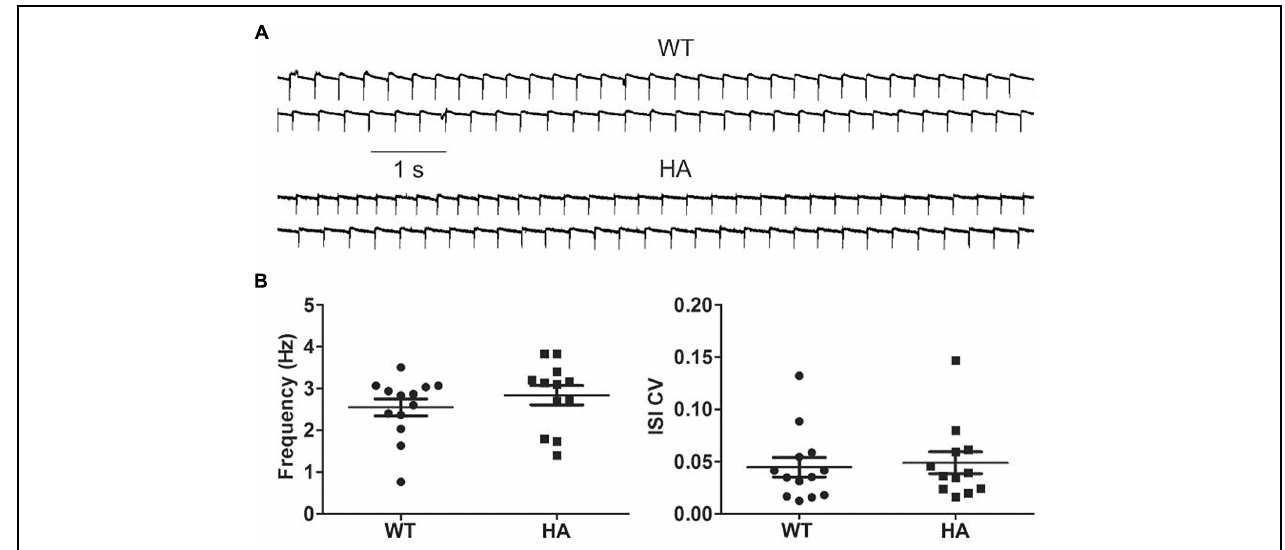
FIGURE 11 | Spontaneous pacemaking in WT and Cav1.3DCRD HA / HA SN DA neurons. (A) Cav1.3DCRD HA / HA (HA) and WT neurons were held in cell-attached mode (sample traces). (B) They typically fired continuously with no statistical differences in frequencies (WT: 2.5 ± 0.2 Hz, n = 13; HA: 2.8 ± 0.2 Hz, n = 12; mean ± SE) and the coefficient of variation of the inter-spike interval (ISI CV) (0.045 ± 0.009 for WT and 0.048 ± 0.010